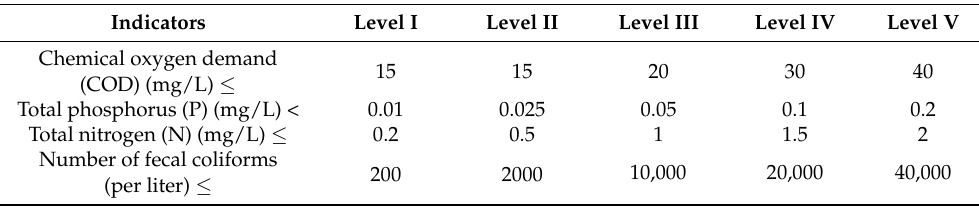
Table 1. The criteria of river water